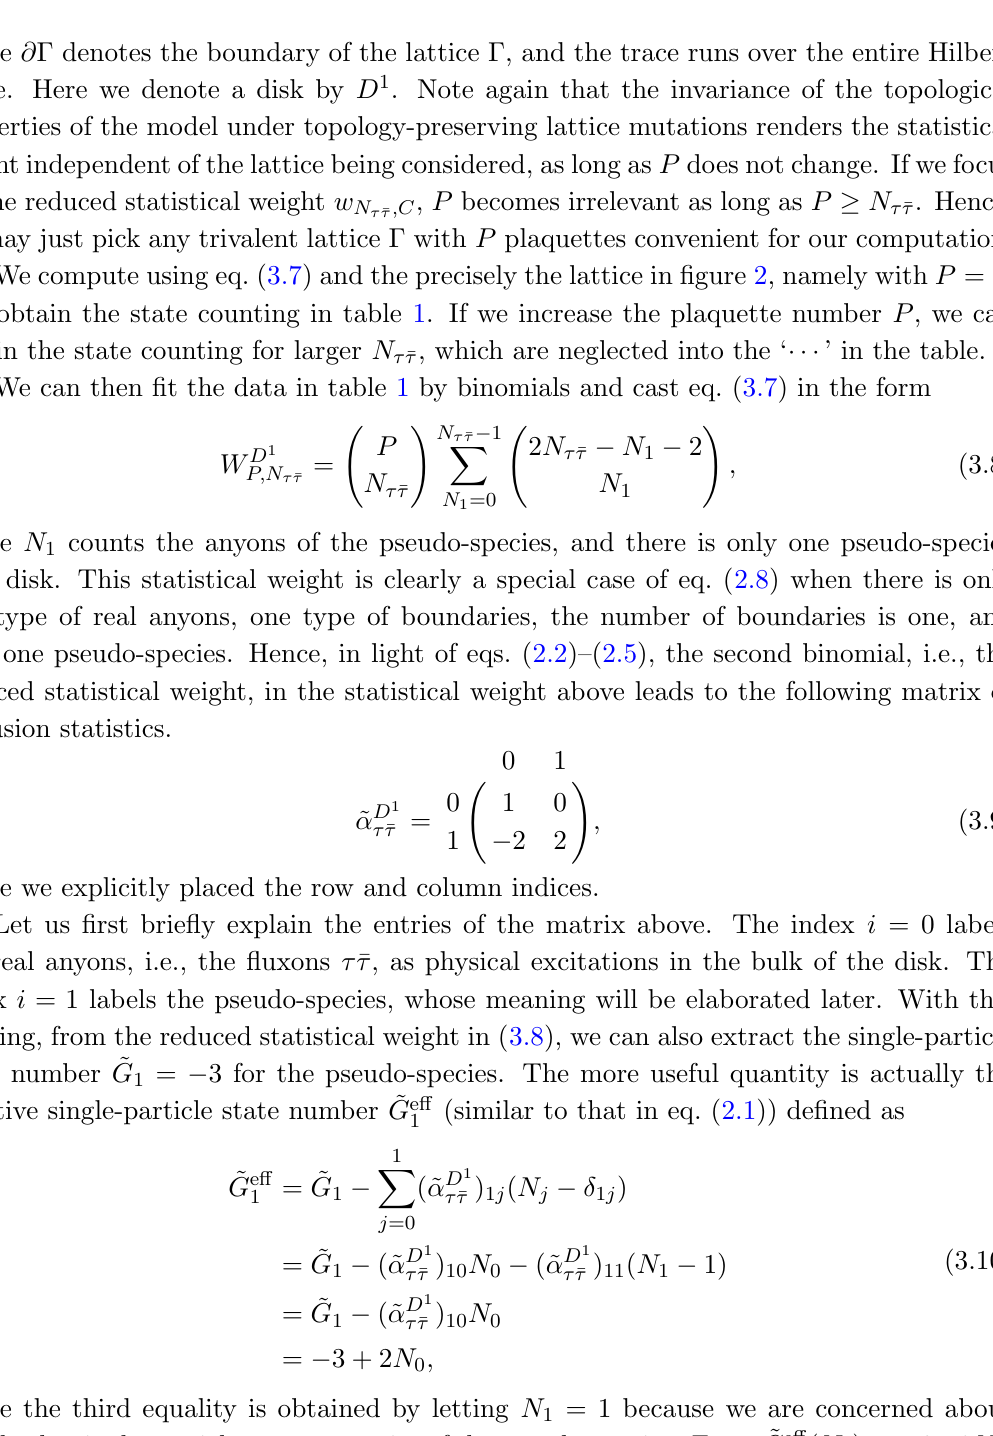
Table 1 . State counting of (cid:28) (cid:22) (cid:28) on a